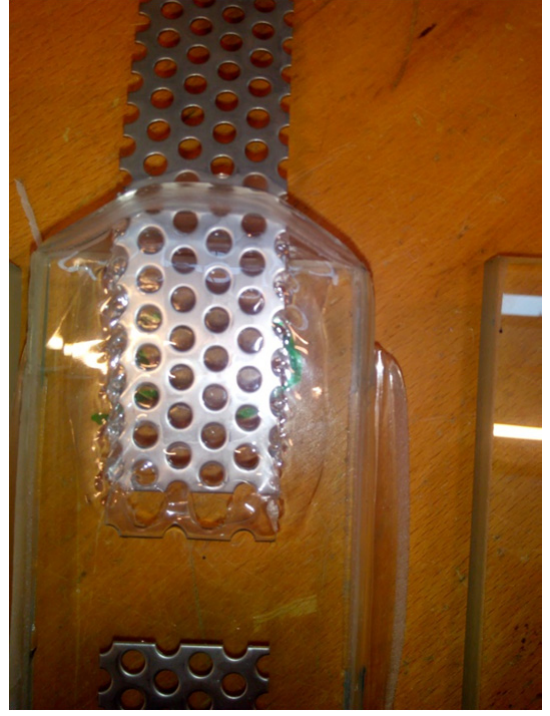
Fig. 14 Pulled out stainless steel of specimen 3 tested at 40 ⁰